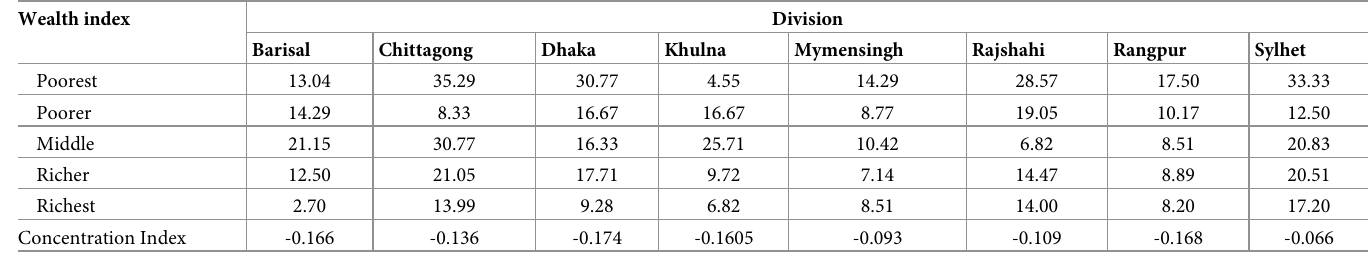
division, respectively, compared to those who were from Mymensingh division.